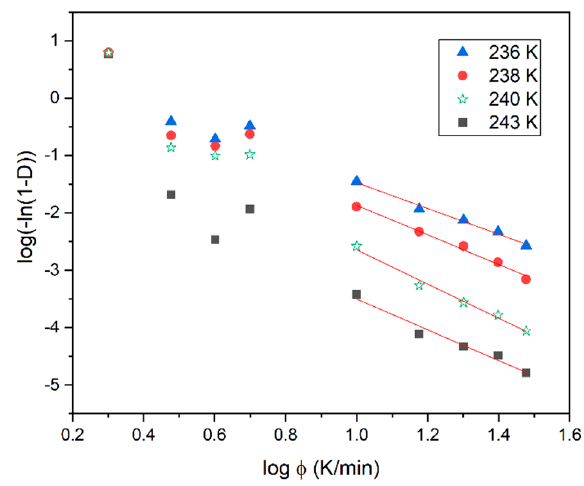
Figure 5. Ozawa plots based on the non-isothermal crystallization DSC data obtained for BBOA.